Question: Describe this figure in one sentence.
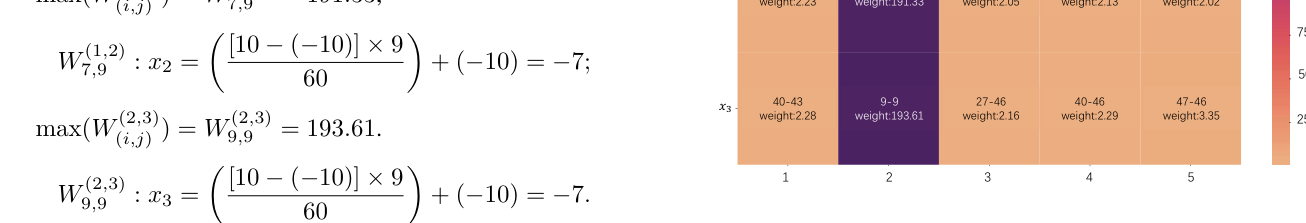
Answer: TOP5 weighted heatmap. Each row represents a dimension of the solution space. In the figure, the colors indicate the top five genetic loci with the highest weights in each dimension. The depth of color reflects the magnitude of the weight value, where a darker color signifies a larger weight value.